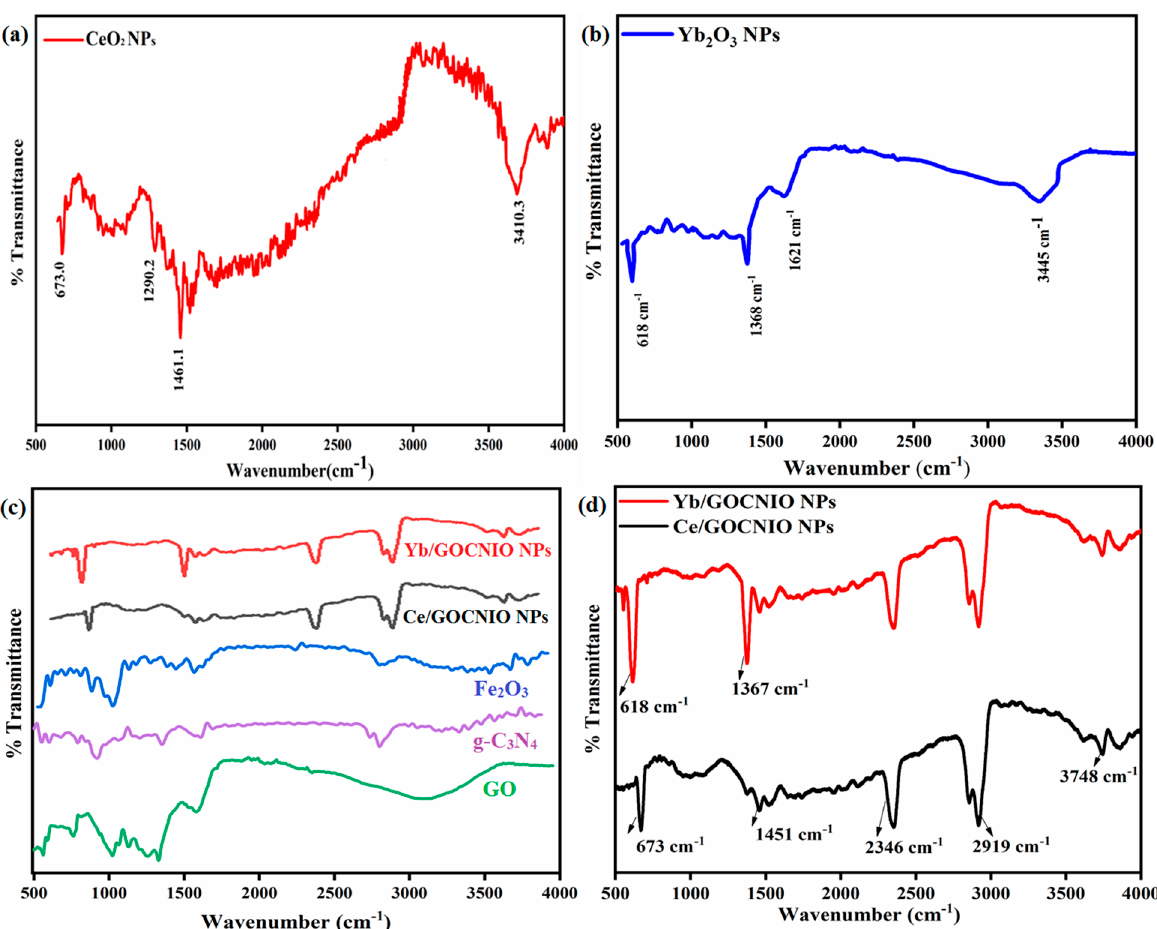
Figure 1. FTIR spectra of ( a ) CeO 2 NPs; ( b ) Yb 2 O 3 NPs; ( c ) GO, g-C 3 N 4 , Fe 2 O 3 , Ce/GOCNIO NPs, and Yb/GOCNIO NPs; ( d ) Ce/GOCNIO NPs and Yb/GOCNIO NPs.